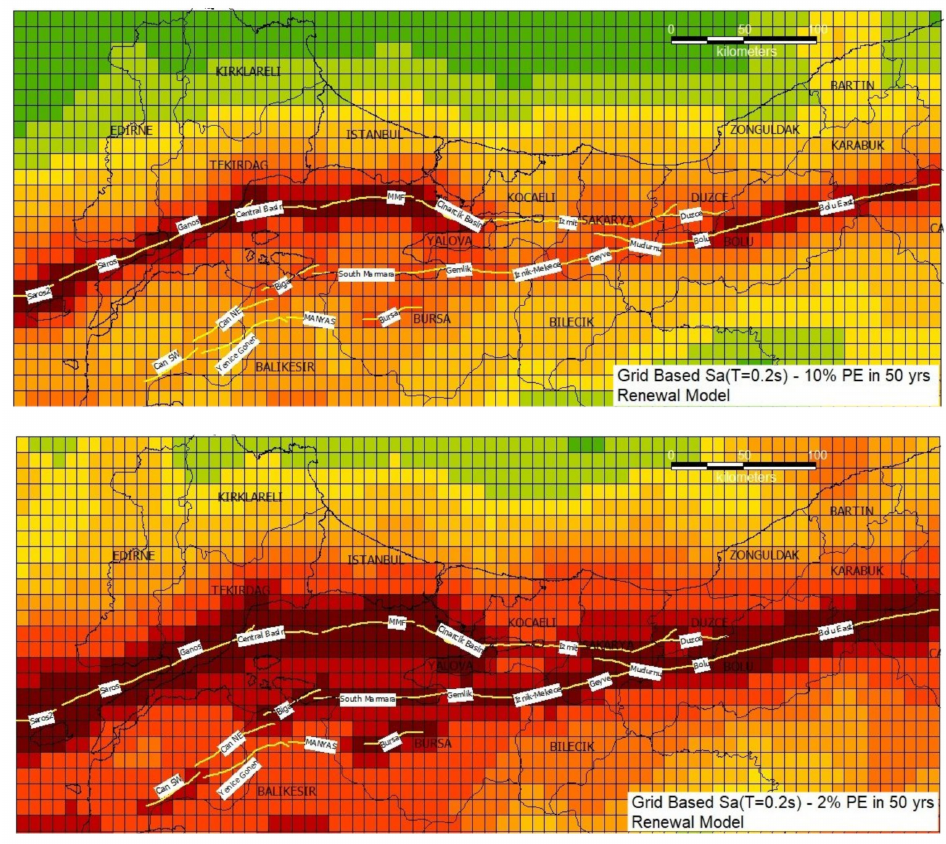
Figure 21. Grid-based SA (T = 0.2 s) distribution at NEHRP B / C boundary site class for 10% (upper panel) and 2% (lower panel) probabilities of exceedance in 50 years (Renewal model). Color coding is the same as in Figure 17.